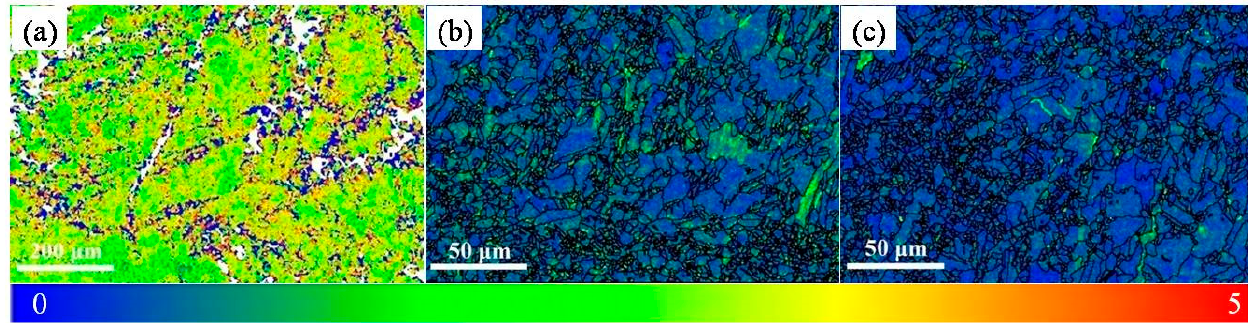
Figure 6. KAM maps of different samples: ( a ) cold rolling; ( b ) annealing for 15 min; and ( c ) annealing for 120 min.